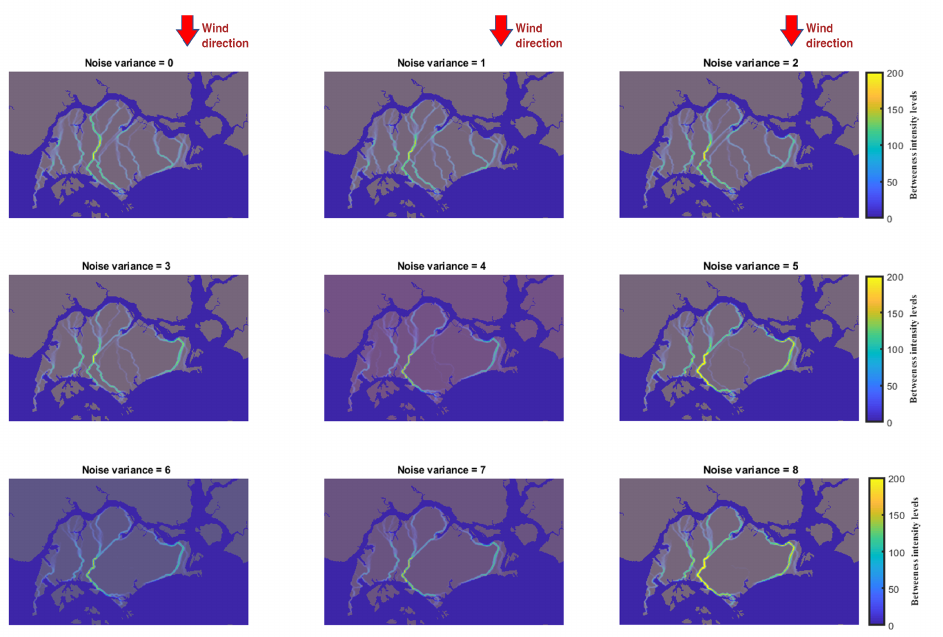
Figure 11. Uncertainty quantification of the algorithm to noisy dataset D , for spatial resolution ∆ ∆ x = y = 100 m, under North–South ( θ A = 0) wind